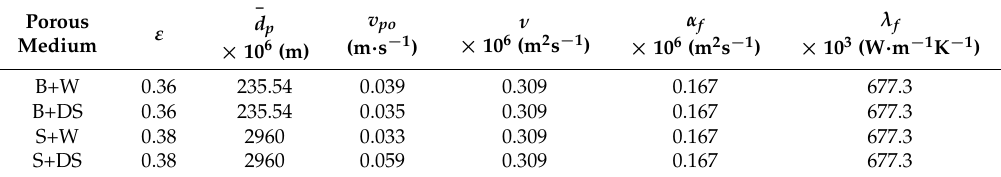
Table 6. Results obtained on the condition of maximum velocity of the liquid in the tray.